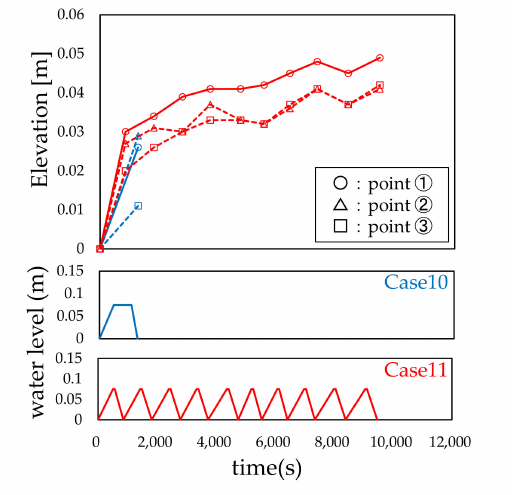
Figure 11. Local scour depth of Cases 10 and 11.